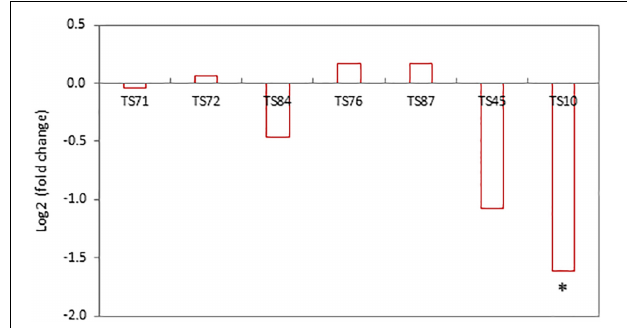
FIGURE 5 | Expression of Zm0001d027859 in PH184C lines with SSILP inserted in the CTL1 region compared to that in the lines with insertion in CTL2. RNA-sequencing was performed to determine gene expression in the leaf tissues of 2-week-old seedlings. The transcript levels of the endogenous genes in the vicinity of CTL1 target sites in seven lines were compared to the CTL2 control. Contrasts are presented as log2 (fold change). Asterisk indicates false discovery-corrected P < 0.05.